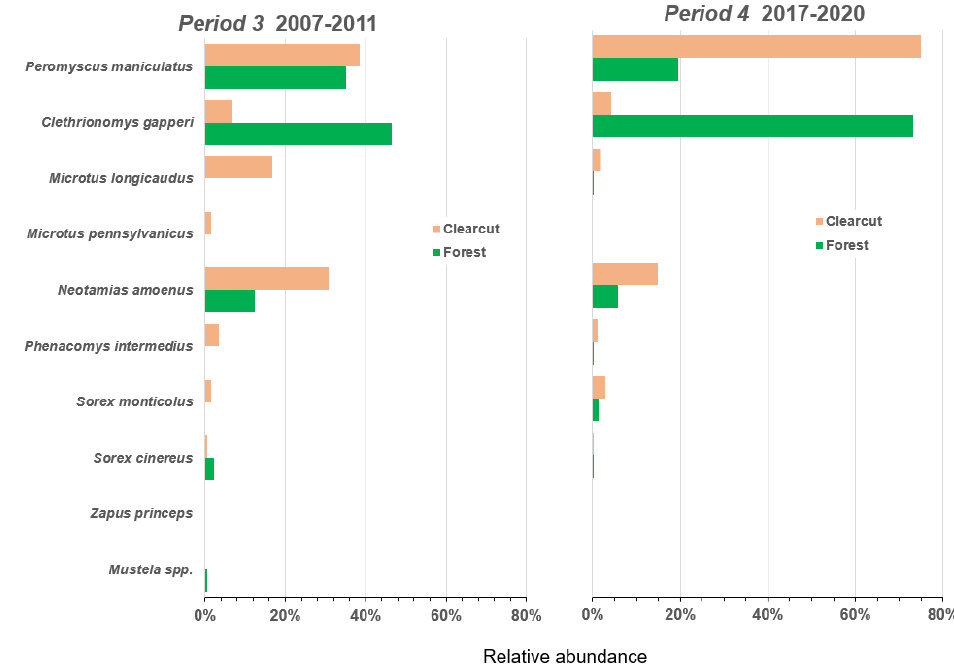
Figure 5. Relative abundance of nine species in the small mammal community in Periods 3 to 4 (2007 – 2011 and 2017 – 2020) in clearcut and forest sites for the CC-FOR study in southern British Columbia, Canada.